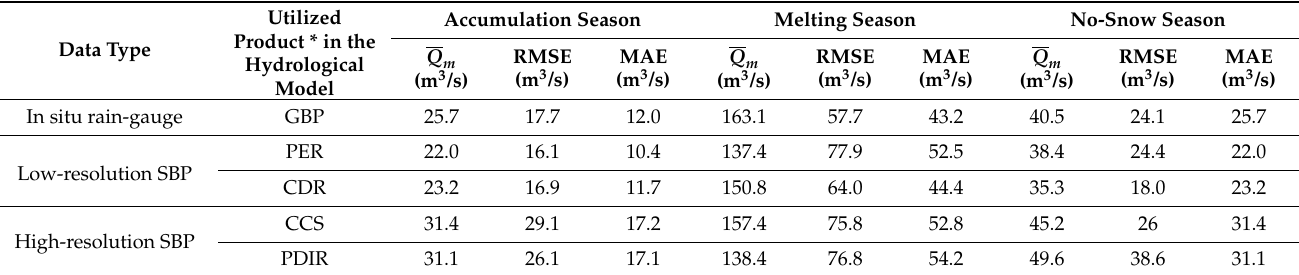
Table 7. Seasonal assessment of the modeled